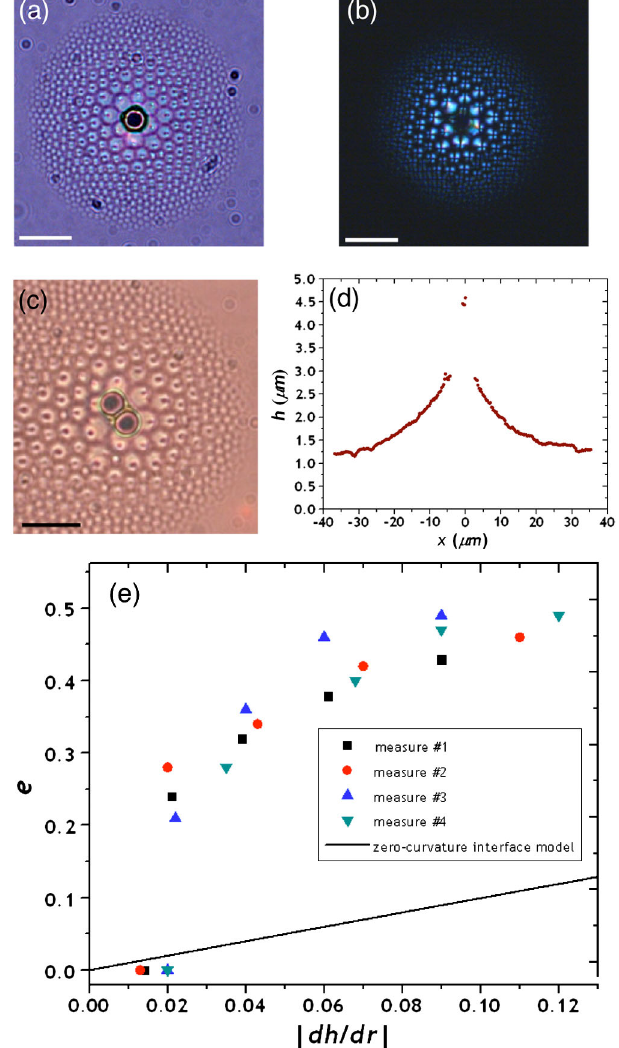
FIG. 1. System A. (a,b) Smectic flower texture organized around a single colloid with homeotropic anchoring in response to the distortion of the LC-air interface produced by the wetting properties of the colloid surface. (a) Bright field. (b) Polarized optical microscopy. (c) Flower texture organized around a col- loidal dimer. (d) Interferometric measurement of the LC-air interface profile around one colloid: smectic film thickness as a function of distance from the colloid center. (e) FCD eccen- tricity vs magnitude of local slope of the smectic-air interface in the radial direction, measured above the middle of the ellipses in four different radial directions. The solid line is the eccentricity given in Eq. (1) corresponding to the limit of zero interfacial curvature. All scale bars are 10 (cid:1) m